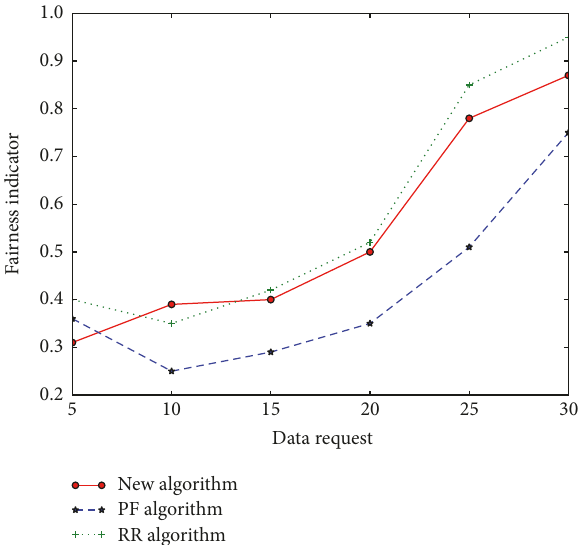
Figure 6: The throughput of different business under different algorithm.